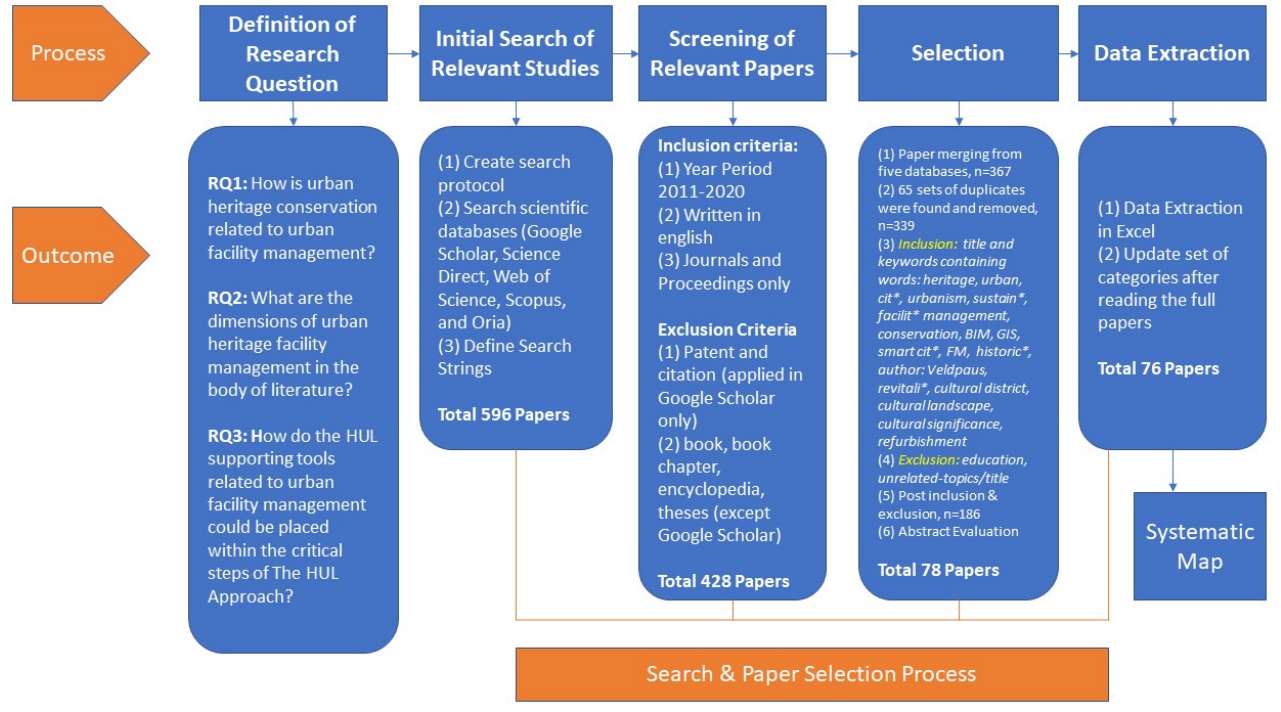
Figure 1. Scoping review process; source: author analysis.